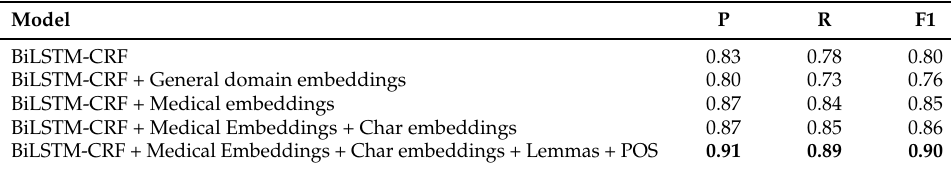
Table 3. Results for Named Entity Recognition.